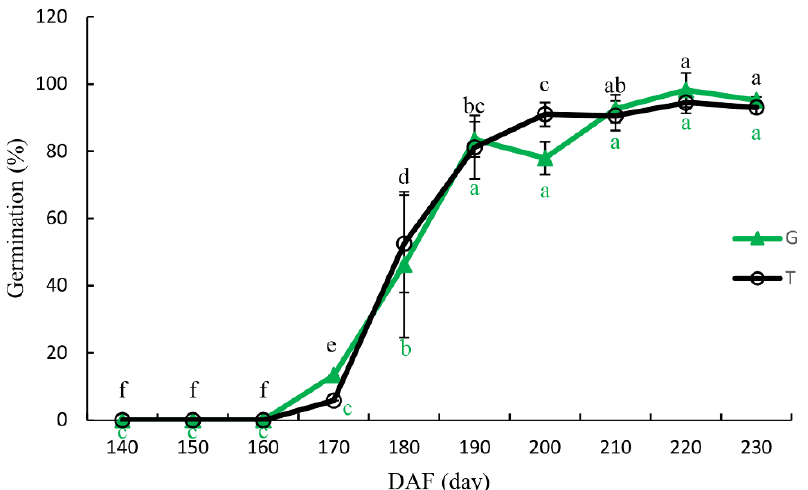
Figure 4. Germination of isolated embryos from trees (T) and the ground (G) of Ginkgo biloba ‘Jiafozhi’. Data are the mean ( ± SD) of three replicates, and bars labeled with different lowercase letters are significant at p < 0.05.